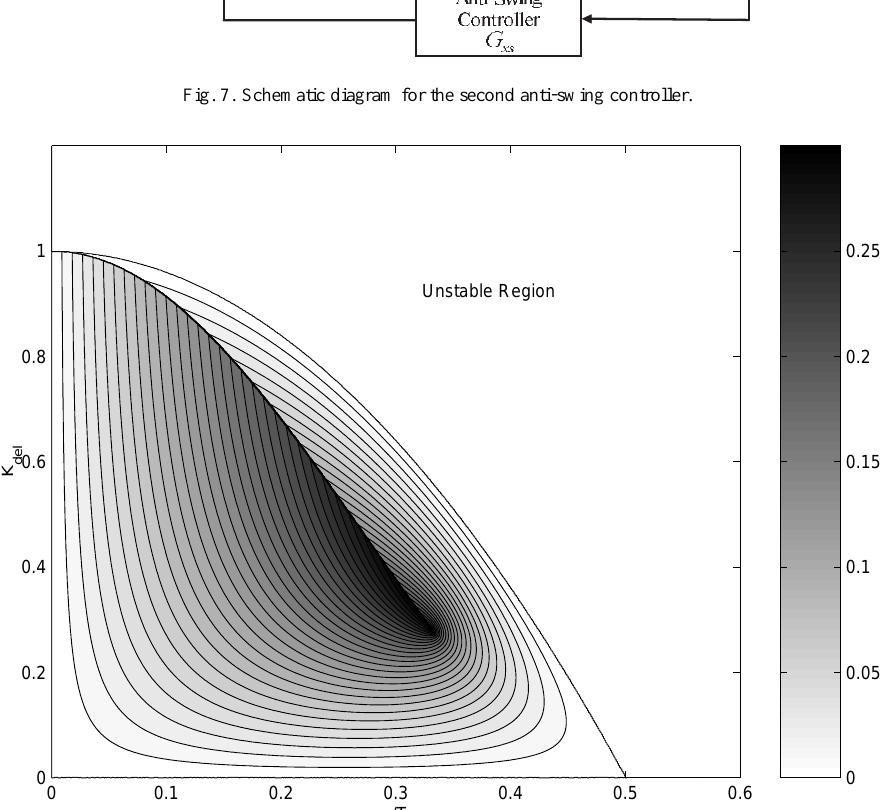
Fig. 8. The damping map of the second delay